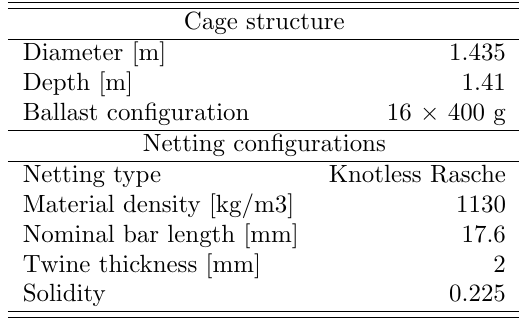
Table 1: Summary of model test setup Lader and En- erhaug